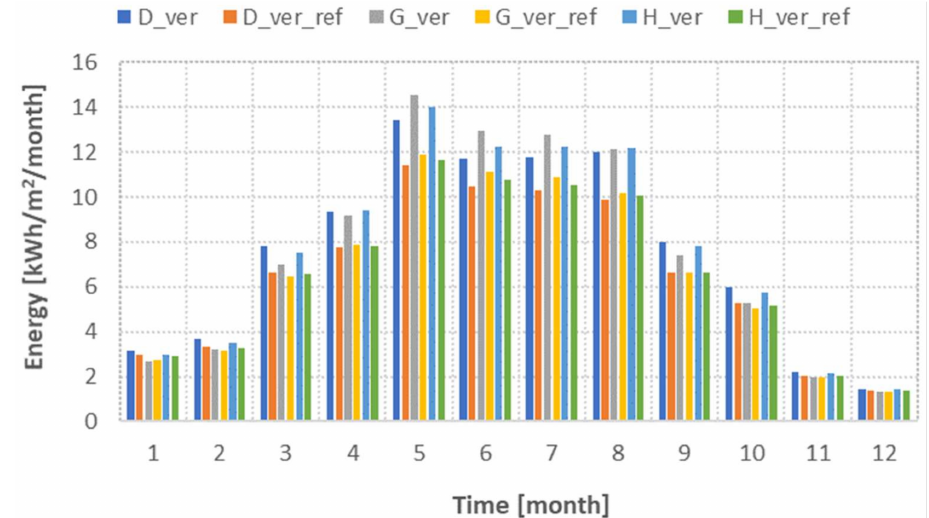
Figure 7. Total monthly energy generated by PV panels.